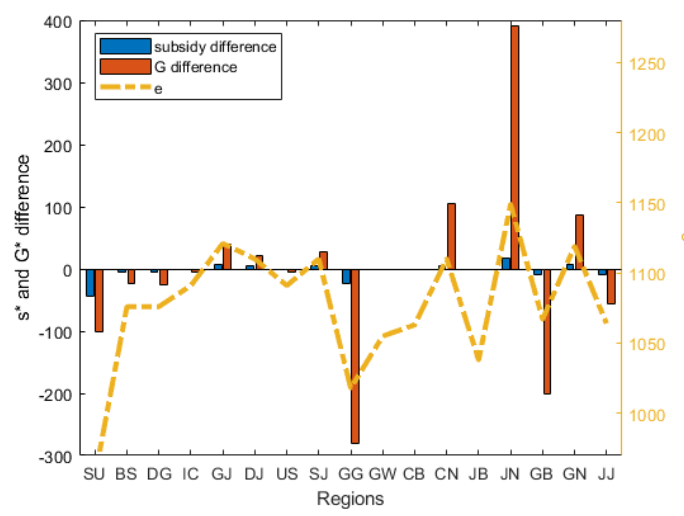
Figure 5. G i and s i comparison between capacity maximization and energy maximization